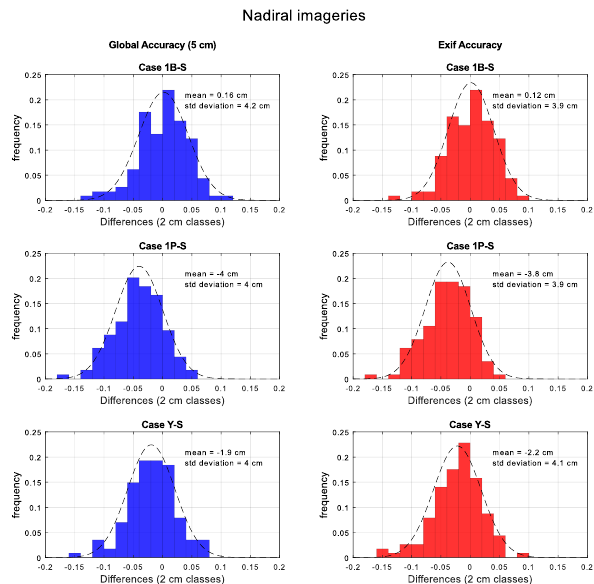
Figure 7. Distribution of the discrepancies computed on the validation points for the nadiral imagery dataset.